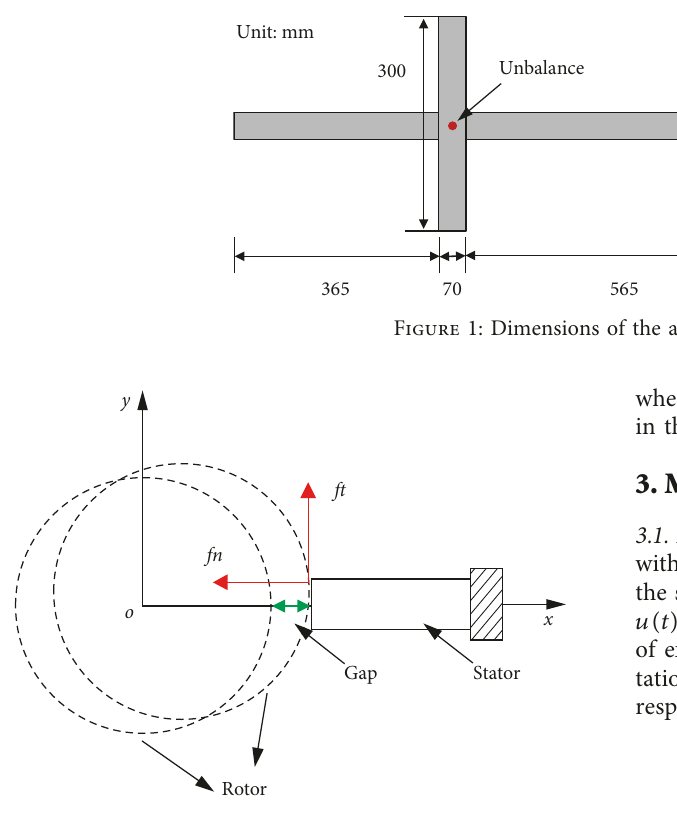
Figure 2: The rub-impact